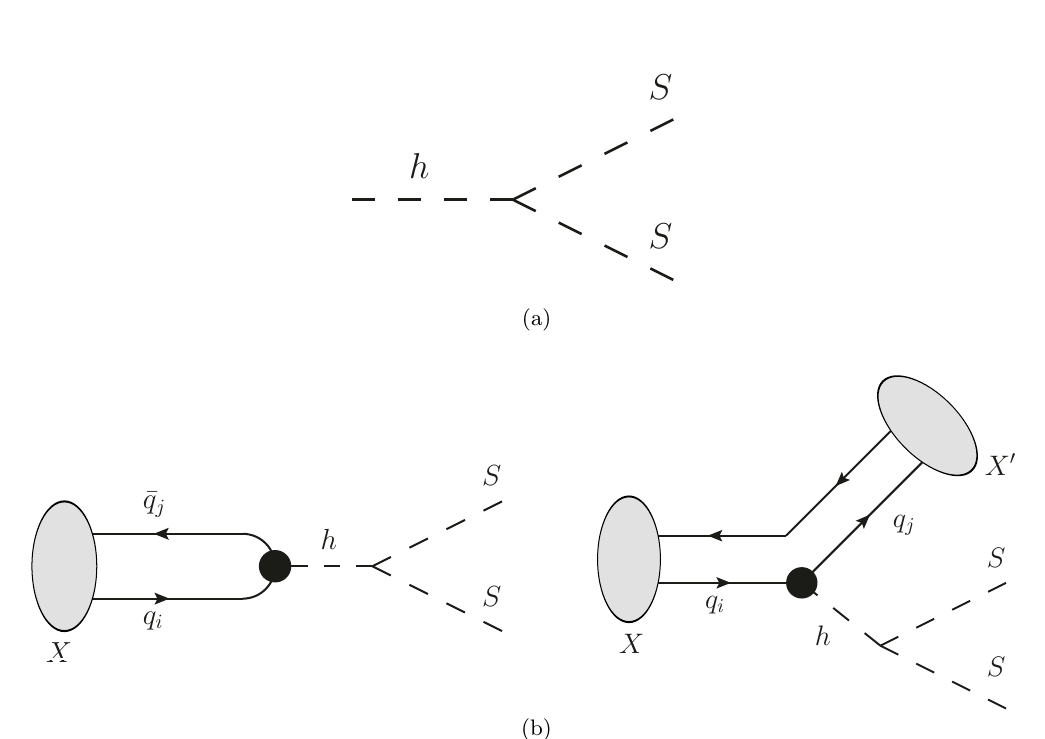
Figure 7 . Diagrams for the production channels of a scalar S through a quartic coupling: decay of the Higgs boson (a), decays of mesons